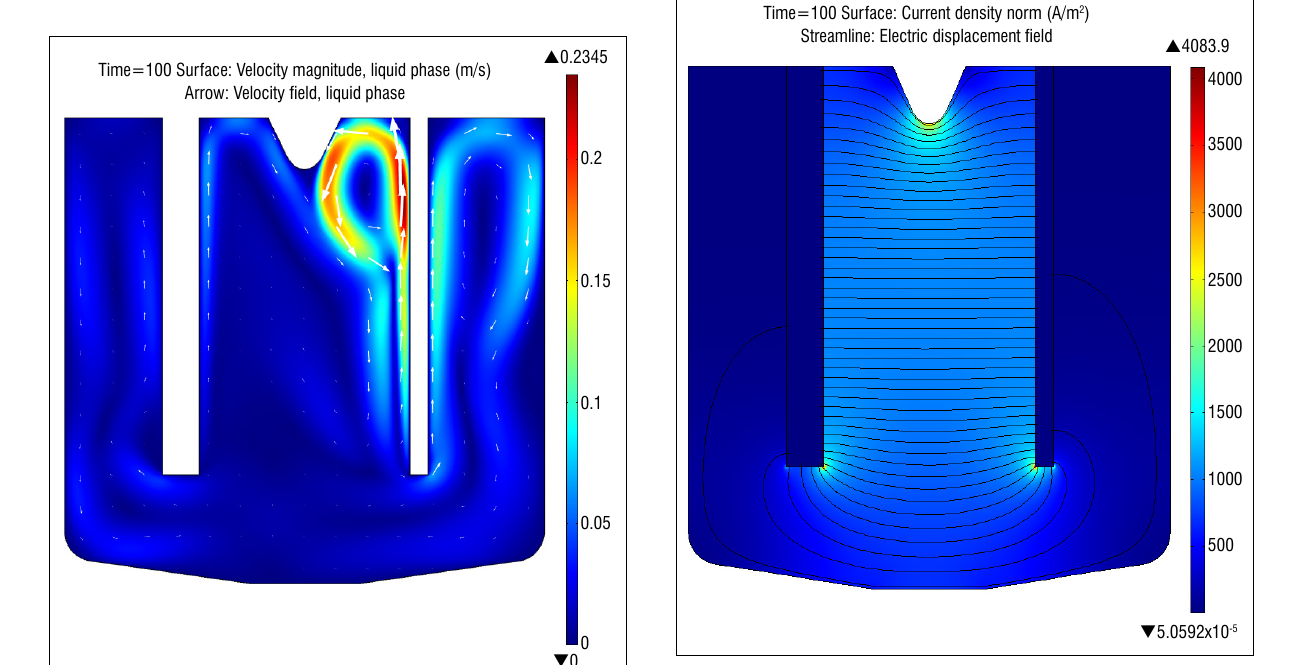
Figure 6: Current density distribution (in A/m 2 ) and electric field streamlines within the electrolysis